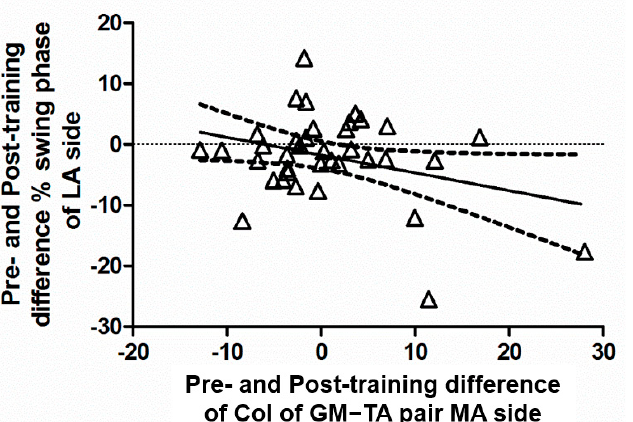
Figure 3. Correlation between changes in co-activation of the leg muscles in the more-affected side (MA, horizontal axis) and those in the swing duration of the less-affected side (LA, vertical axis). Positive values indicate a post-rehabilitation increase with respect to the baseline. GM–TA (Medial Gastrocnemius and Tibialis Anterior